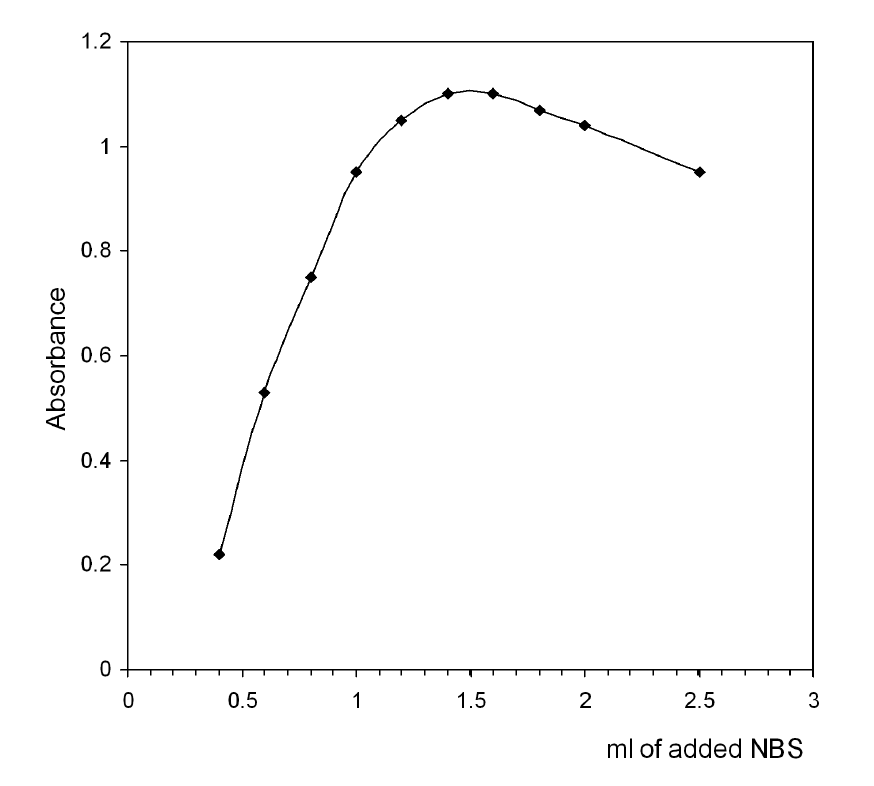
Fig. 2 Effect of ml added of 100 µ g ml − 1 NBS on the intensity of the color produced during the reaction (9.0 µ g ml − 1 DIL.HCl, 0.4-2.5 ml